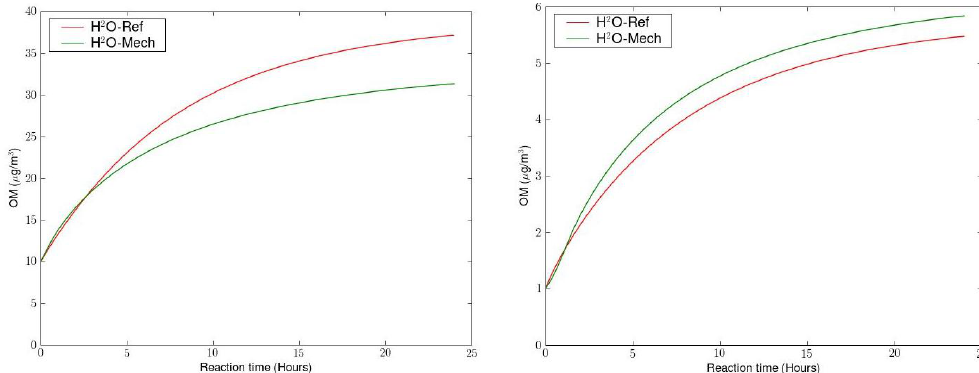
Fig. 2. Concentrations of SOA from primary SVOC oxidation computed with the two mechanisms for 10 µ g m − 3 (left) and 1 µ g m − 3 (right) of POA. EC ( µ g m − 3 ) OM ( µ g m − 3 )